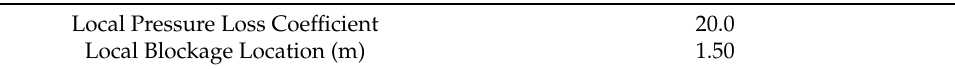
Table 7. 2 × 1 local blockage from the FLOCAL developer benchmark.